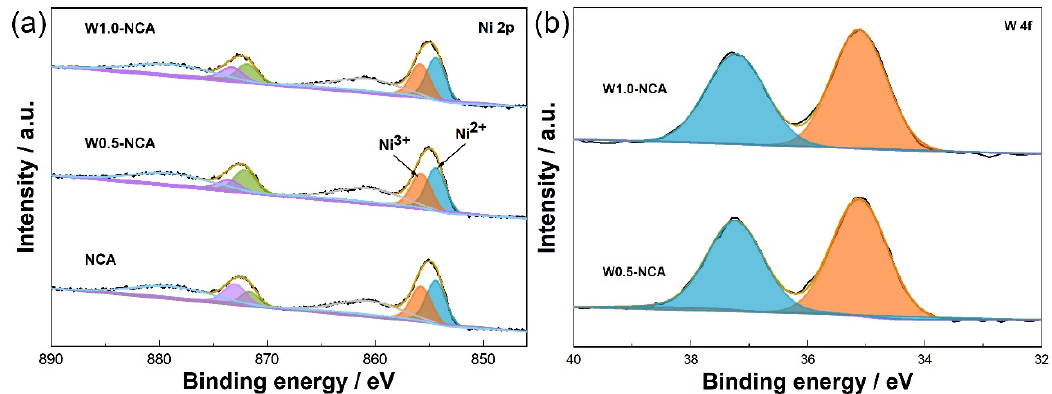
Figure 4. XPS spectra of ( a ) Ni 2p, ( b ) W 4f for NCA, W0.5-NCA, W1.0-NCA cathodes.